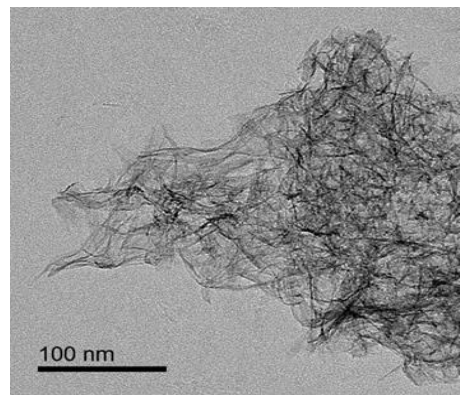
Figure 10. TEM morphology of the PB (concentration of NaAlO 2 solution, 0.1. mol/L; gas – liquid ratio, 3:1; rotating speed of CF-RPB, 600 rpm).